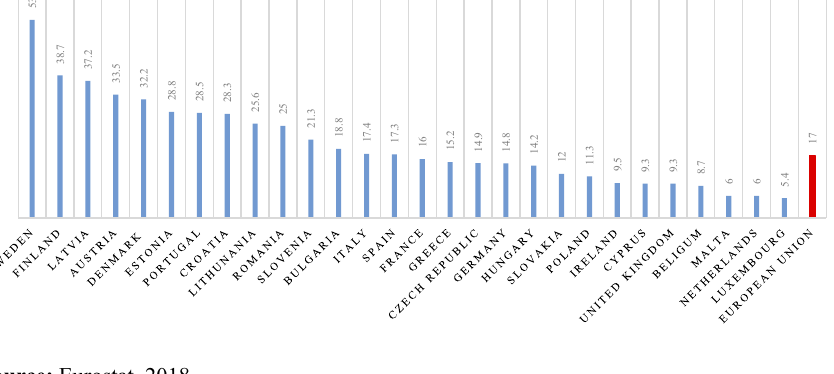
Figure 6. Share of energy from renewable resources in the EU member state (in % of gross fi nal